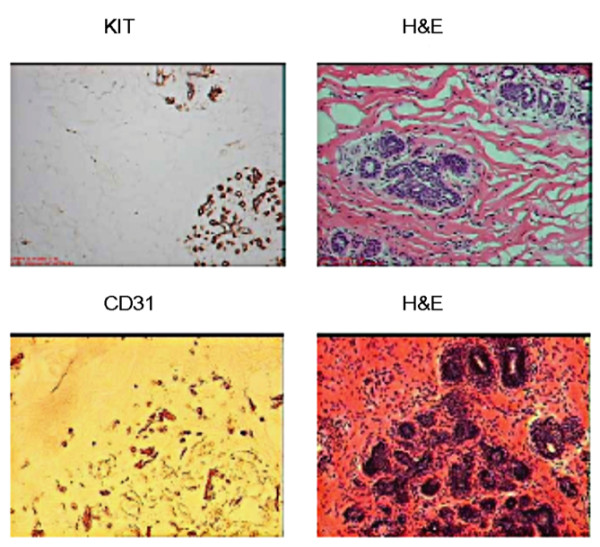
Immunostaining of normal breast tissue with anti-c-kit and anti-CD31. H&E, hematoxylin and eosin.